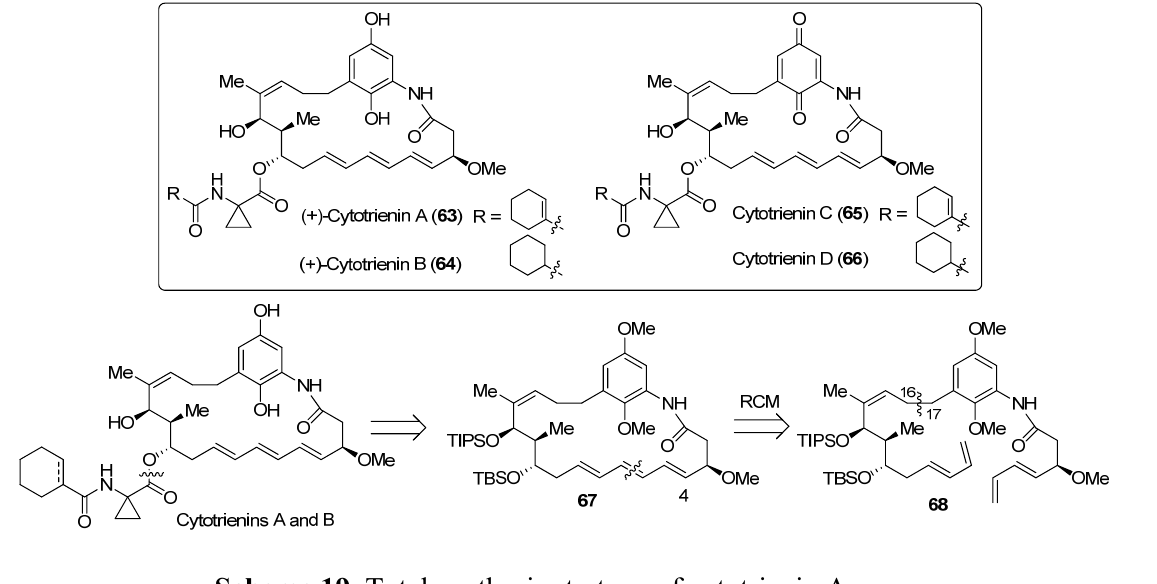
Scheme 19. Total synthesis strategy of cytotrienin A